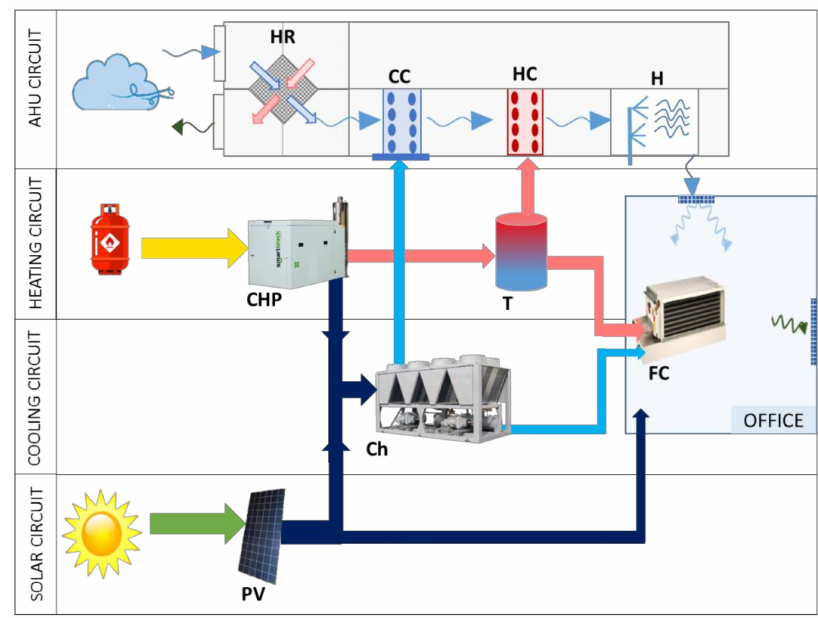
Figure 10. Scheme of the total